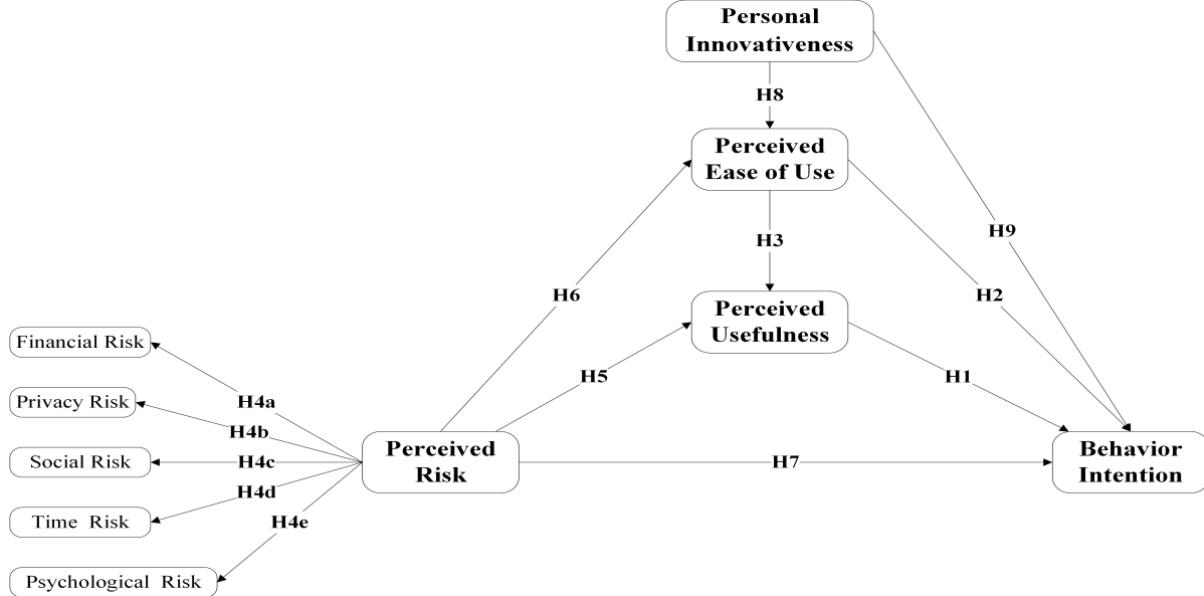
Figure 1. Research model based on the technology acceptance model and perceived risk theory. Personal innovativeness had effects on behavior intention and perceived ease of use. H: